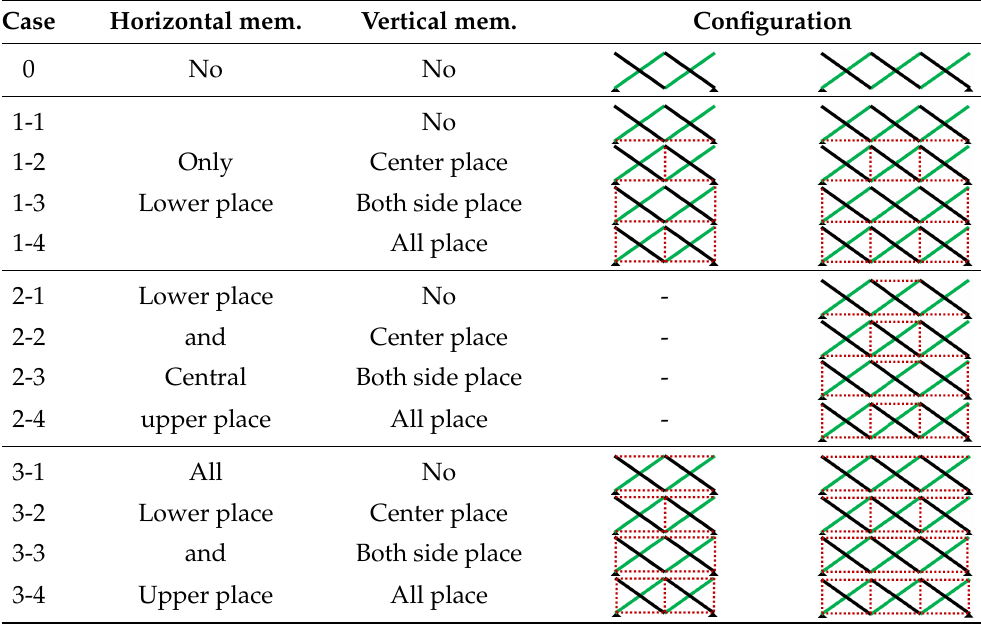
Table 1. Numerical cases with different reinforcing patterns. Case Horizontal mem. Vertical mem.